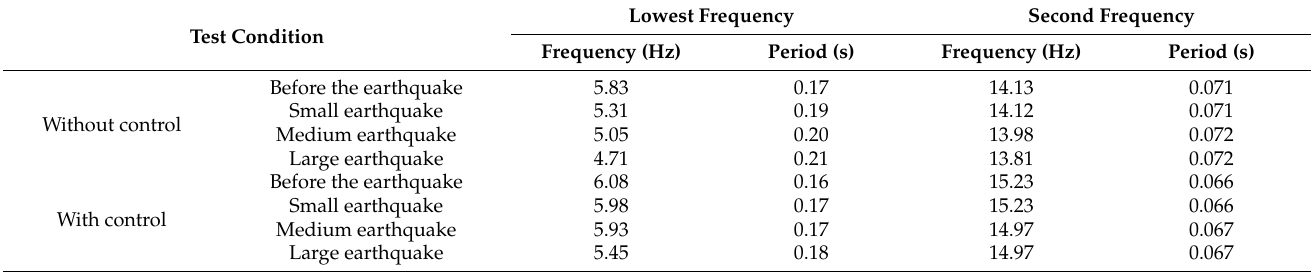
Table 2. Natural vibration frequency and period of the Small Wild Goose Pagoda model structure.